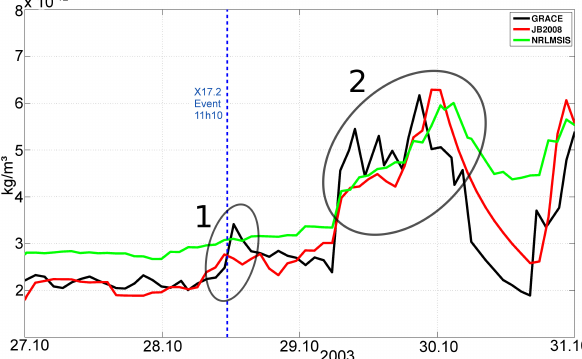
Fig. 7. Comparison of dayside atmospheric densities during the Halloween period based on GRACE accelerometer measurements (black line) and the empirical thermosphere models JB08 (red line) and MSIS00 (green line). The graphic shows the dayside maxima for each satellite